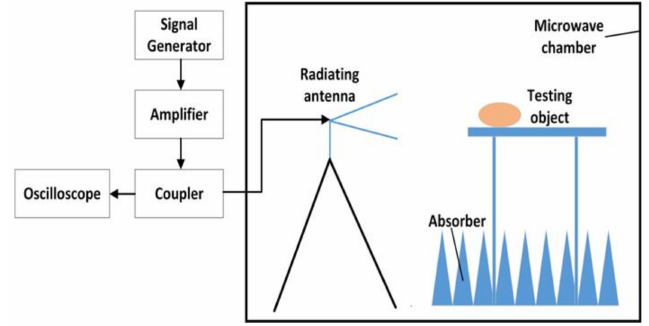
Figure 1. Schematic diagram of experiment set up of the exposure